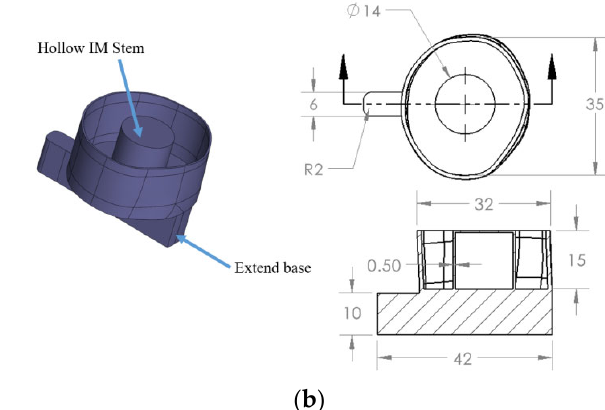
Figure 1. Geometry of the novel osseointegration implant: ( a ) developed based on Patent US20200188140 and ( b ) modified oval ‐ shape implant with hollow IM stem for the experiment, dimension in mm.